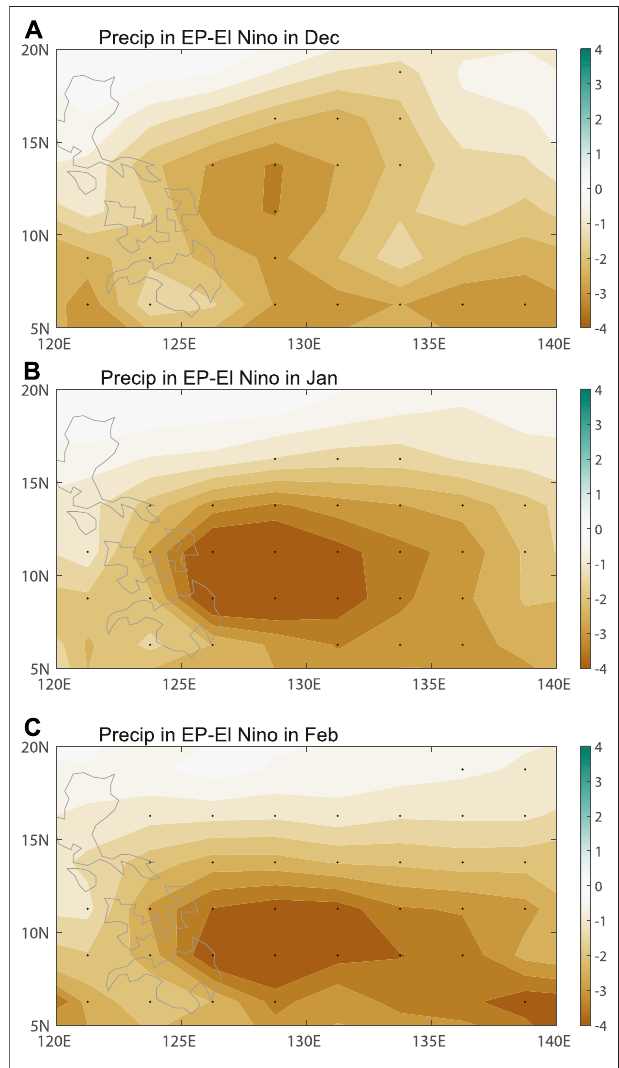
FIGURE 1 | Composite precipitation anomalies (units: mm day − 1 ) derived from the CMAP dataset during El Niño mature phases in (A) December, (B) January, and (C) February. Dotted areas indicate the 0.05 signi fi cance